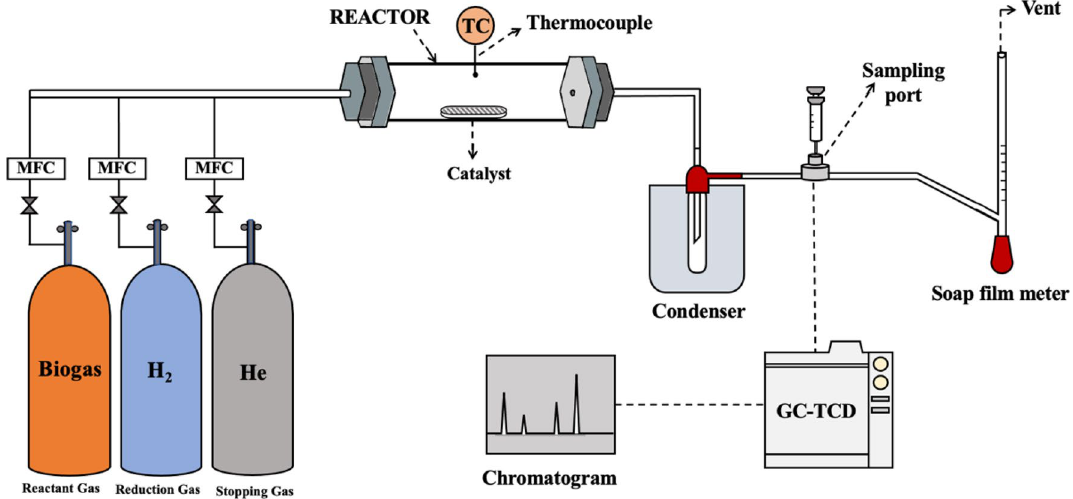
Figure 1. Schematic diagram of a process for directly converting biogas into hydrogen-rich syngas and carbon ogy and particle-sized distribution of synthesized CNTs were identified by a Field-emission scanning electron microscope (FE-SEM, JEOL, JSM-7610F) at the operating voltage of 10 kV. The internal structure of nano carbon deposited on the spent catalyst was characterized by a Field-emission transmission electron microscope (HR- TEM, JEOL, JEM-3100, Japan) at the operating voltage of 300 kV. The purity of the synthesized carbon nanotube was determined by thermogravimetric analysis (TGA, Metteler Toledo, TGA/DSC1) with an oxygen gas flow rate of 50 ml/min and a heating rate of 10 °C/min from room temperature to 800 °C. The hydrogen programmed reduction (H 2 -TPR, BEL JAPAN, BELCAT-B) method was used to assess the reducibility and metal-supported interaction of calcined catalysts. Prior to measurements, 100 mg of calcined catalysts was pretreated at 200 °C for 1 h under a He flowrate of 30 ml/min. Afterward, the H 2 -TPR profile was obtained using a mixture of 5% H 2 / Ar flowing at a rate of 30 ml/min with the sample heated from 100 to 900 °C with a fixed heating rate of 10 °C/ min. The chemical composition of the reduced catalysts was analyzed by X-ray fluorescence (XRF, S8 TIGER, Series 2). The graphitic and disorder carbon of synthesized CNTs was examined by Raman spectrophotometer (PerkinElmerÒ Spectrum™ GX). The textural properties of spent catalysts were identified by the N 2 sorption measurement (Micromeritics, TriStar II 3020). Production process. The evaluation of the catalytic activity was performed under atmospheric pressure.